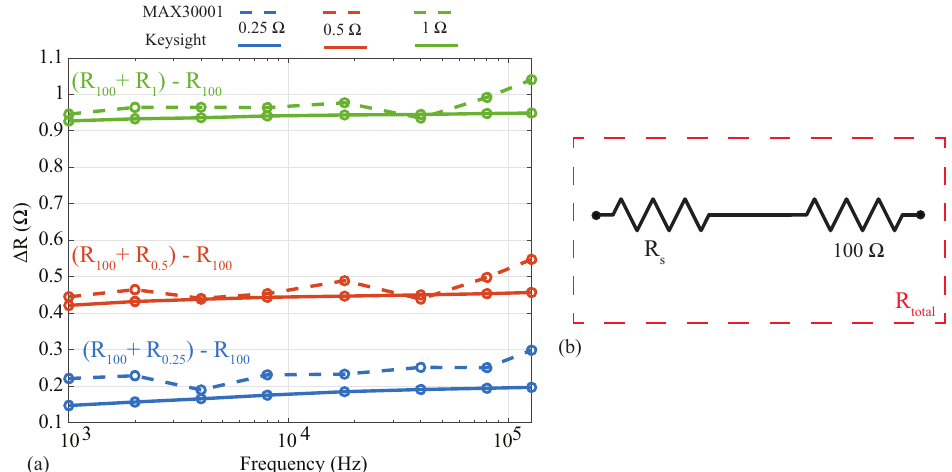
Figure 6. Absolute differences in resistance between ( a ) MAX3000x (dashed) and Keysight E4990A (solid) after addition of ( b ) 0.25 Ω , 0.5 Ω , and 1.0 Ω series resistors ( R s ) to a 100 Ω